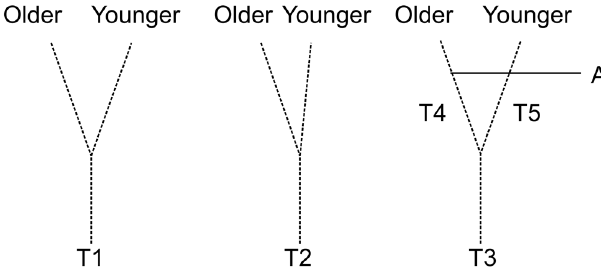
Figure 8. Relative ages of trail segments. Left , map showing a trail, T1 , with two branches that diverge from the stem at similar angles; middle , map showing a trail, T2 , with a bend and a younger branch oriented closely to a portion of the stem; right , map showing trail segments T3 , T4 , and T5 and an agricultural wall, A , whose relationships with T4 and T5 establish that T4 is older than T5 (see fig. 3).